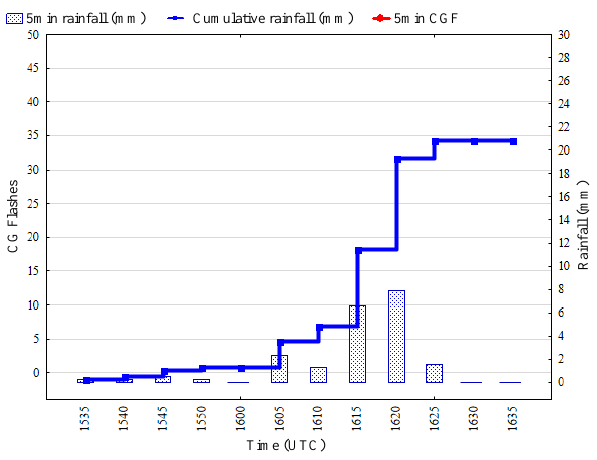
Figure 10. Critical interval time series for debris flow event of 20 July 1999. This is an event from the STH group and debris flow initiation was observed at 16:35UTC.